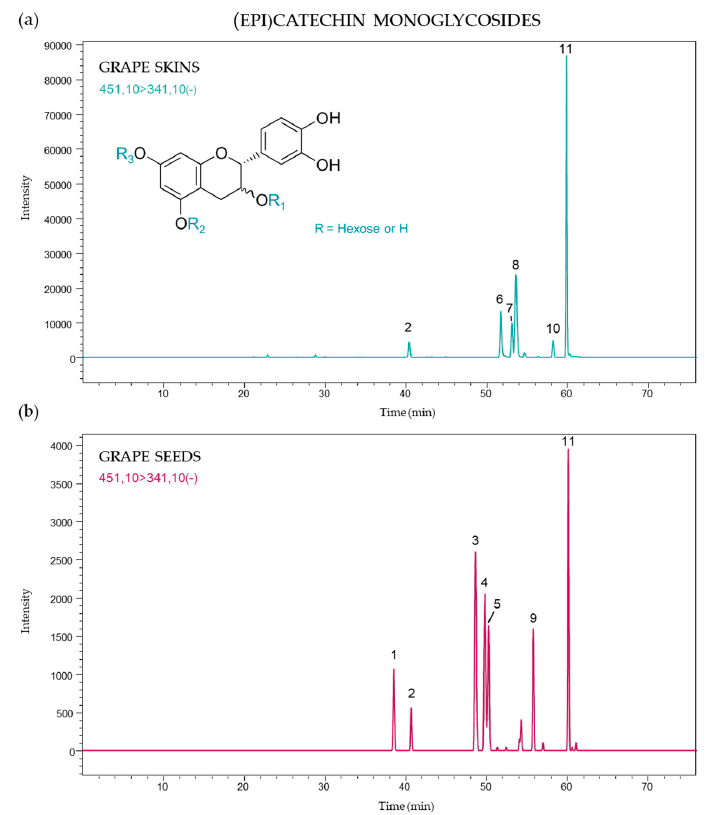
Figure 2. (Epi)catechin monoglycoside profile of ( a ) skins and ( b ) seeds from Vitis vinifera grapes using multiple reaction monitoring (MRM) [451 → 341]. multiple reaction monitoring (MRM) [451 →